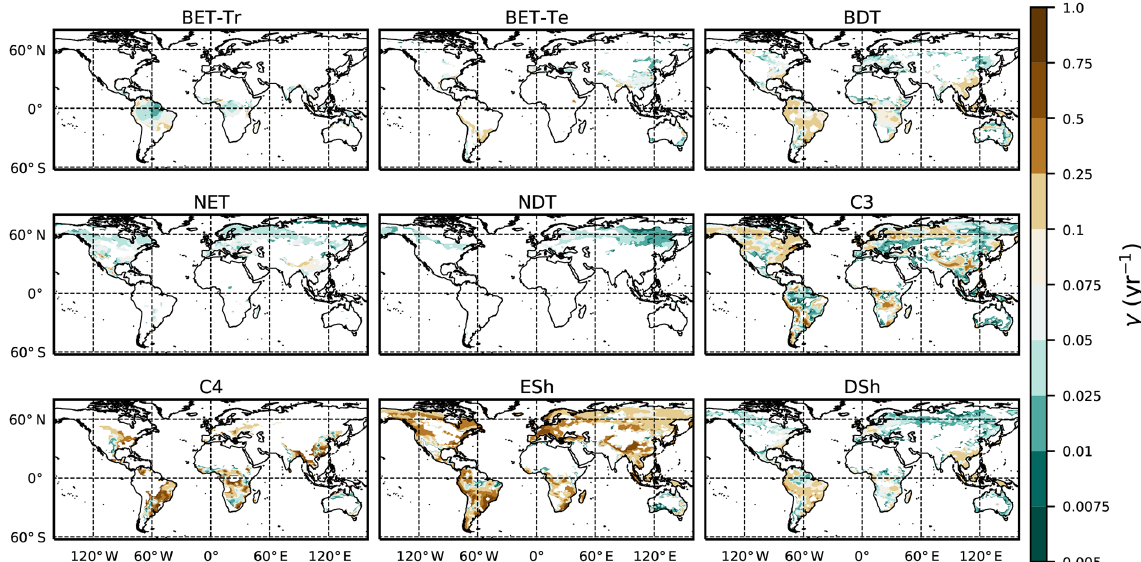
Figure 6. Diagnosed maps of mortality rates γ for each PFT, as required for consistency with the ESA observations and the UKESM growth rates. White areas correspond with zero coverage and/or zero growth.